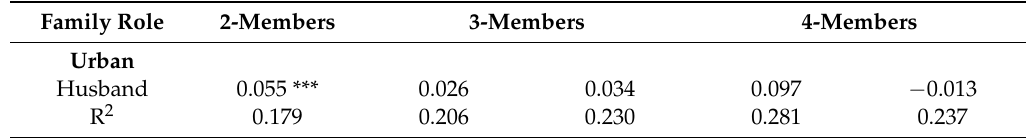
Table A2. Labor time-controlled effect regression results (dependent variable: Ln individual calorie). Family